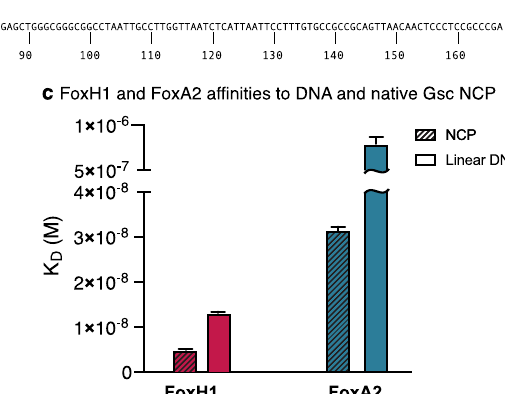
mousesequencesarehighlyconserved. b Titrationofthenative Gsc 167withFoxH1 FHdomain.The Gsc 167 sequenceand theFoxH1 motif are indicated. DNAladderis includedasareferenceforthelinearDNA. c Comparisonofthebindingaf fi nitiesof FoxH1 and FoxA2 to the Gsc sequence (NCP and linear DNA). Bars represent fi tted K D values and error bars represent standard error of the fi t ( n =5). Source Data are